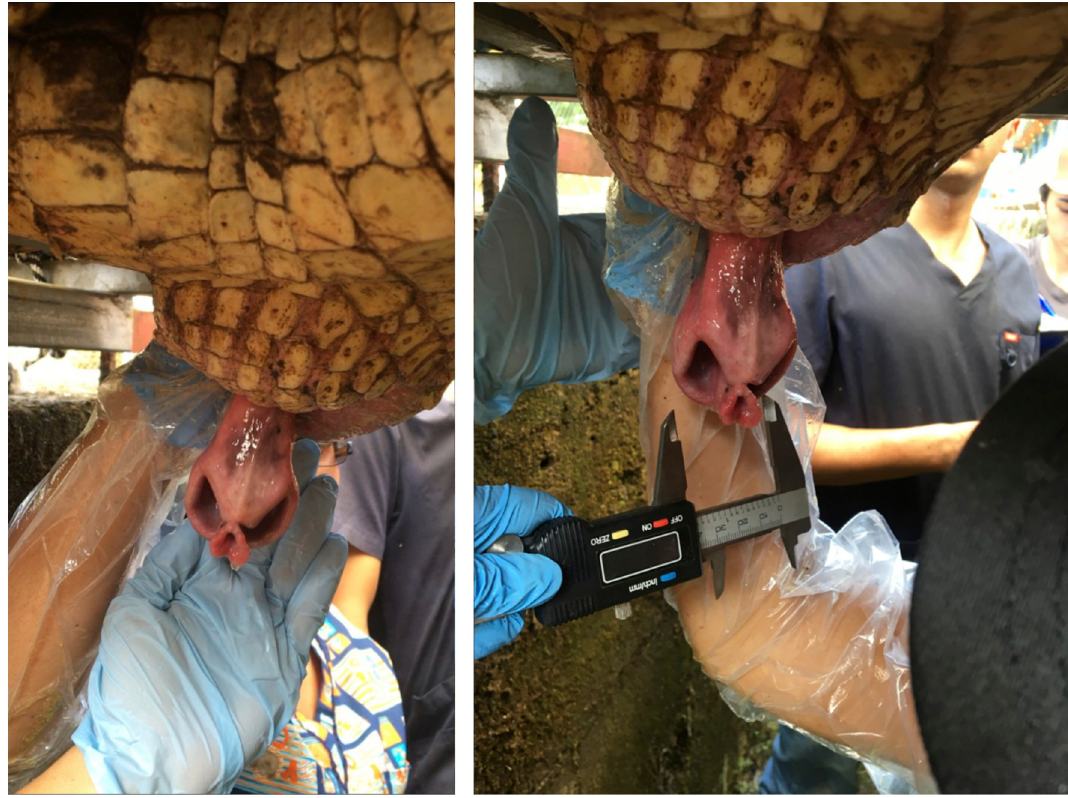
Fig 1. American crocodile ( Crocodylus acutus ) sperm collection by manipulation and digital massage of the penis and ductus deferens, introducing a gloved hand in the opening cloaca.